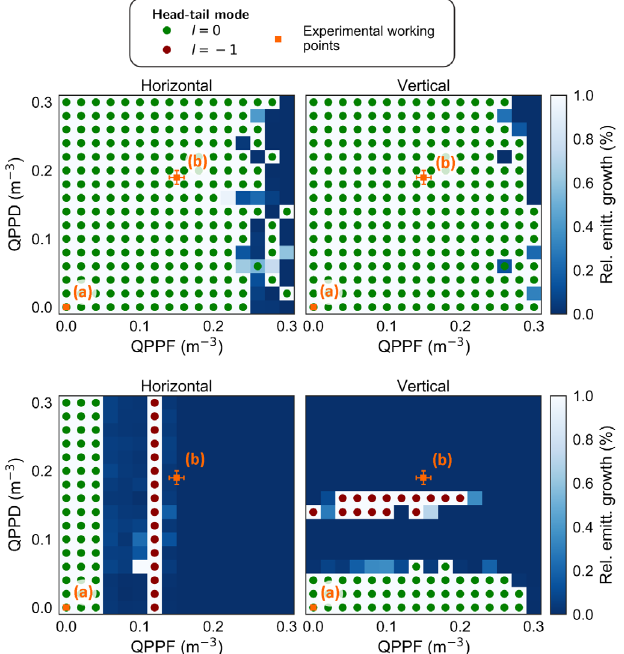
FIG. 9. Two P y HEADTAIL studies showing the predicted head- tail instabilities as a function of the sextupole knobs QPPF and QPPD. Labels (a) and (b) mark the two working points used during the experiments. Top: Results obtained without Q 00 x;y effects but including the transverse amplitude detuning coeffi- cients from the sextupole knobs. Bottom: Results obtained including also Q 00 x;y